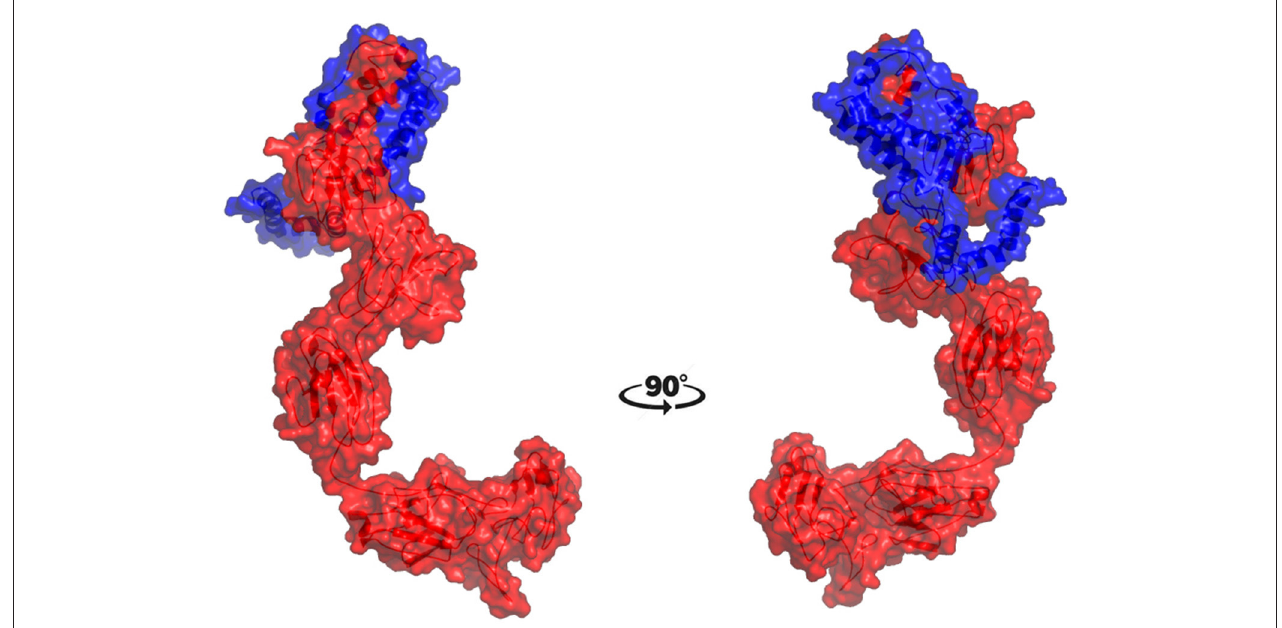
FIGURE 4 | Stereo surface docking view of IL10RA wildtype (RED color) with IL10